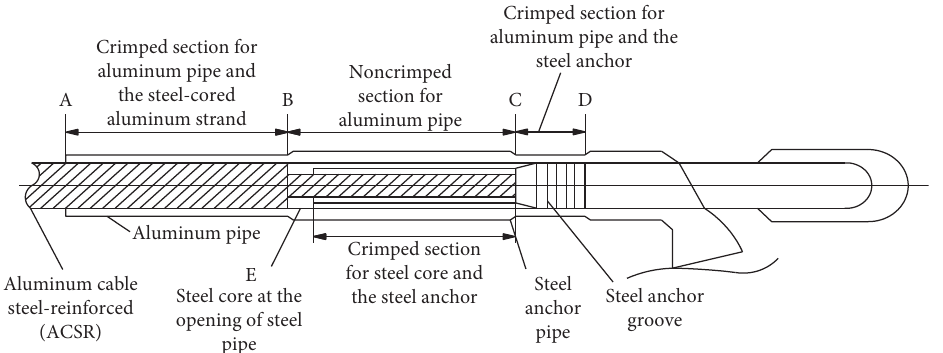
Figure 2: Typical compression-type strain clamp.